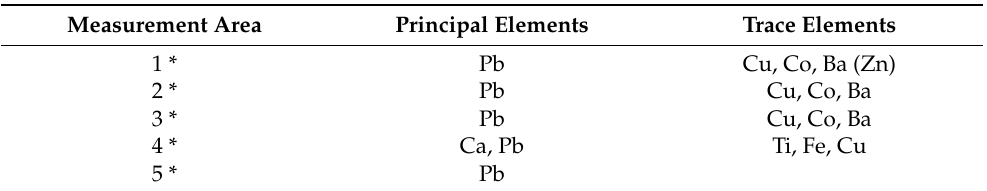
Table 2. Elements detected by XRF on the areas described in Table 1, with the exception of Area 8, which is extensively discussed in the text.